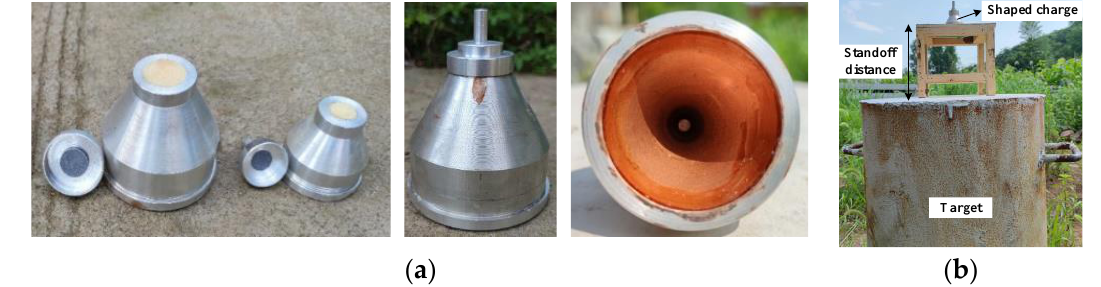
Figure 3. Shaped charges photos and experimental layout: ( a ) Shaped charges photos; ( b ) Experi- mental layout.